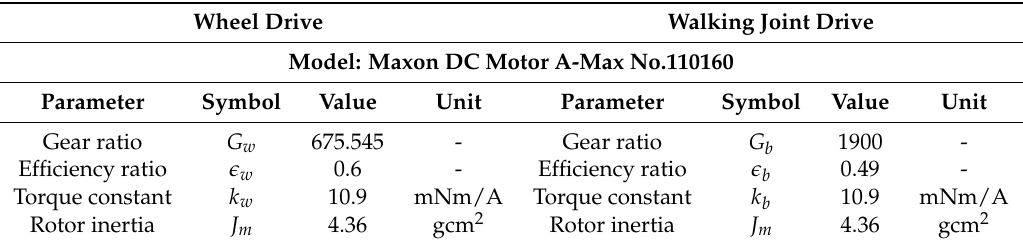
Table 2. Rover ExoTeR motor parameters.